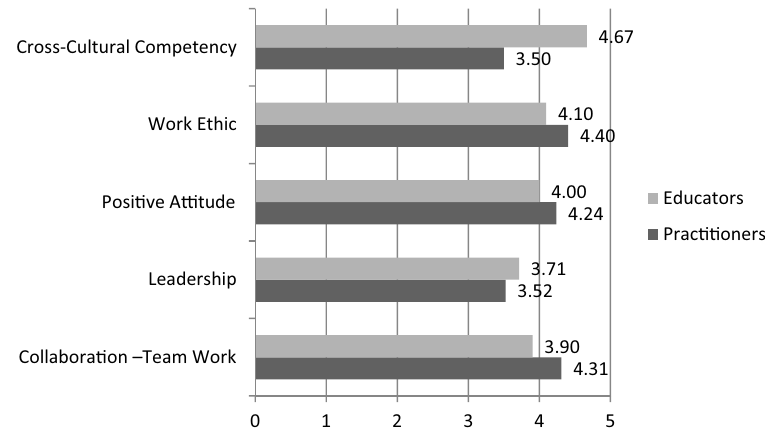
Figure 5: Social competences in the opinion of practitioners and educators. Source: author ’ s own study.